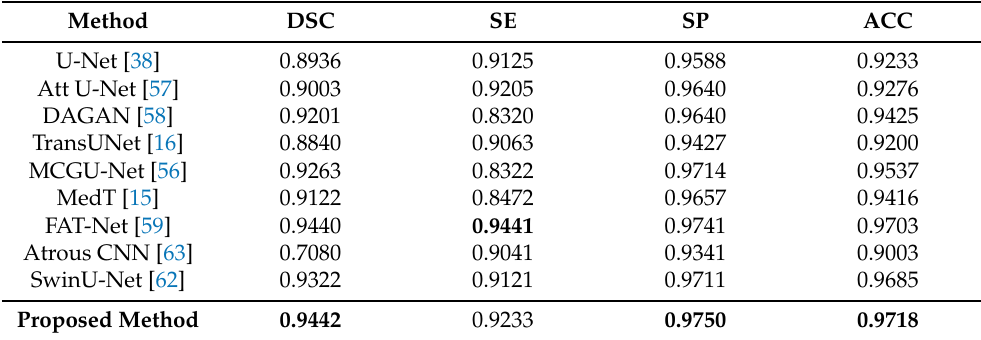
Table 3. Comparison results of the proposed method against the SOTA approaches on the PH 2